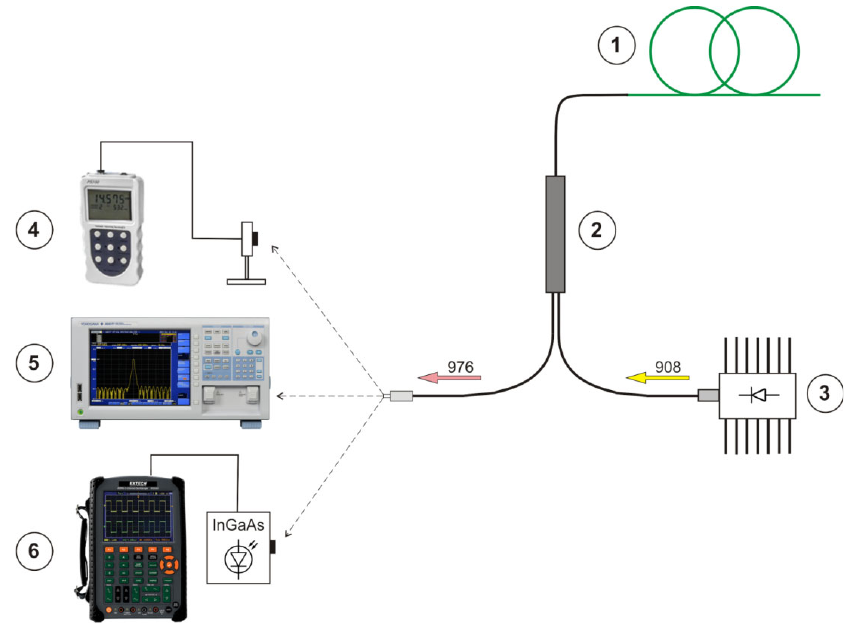
Figure 1. Scheme of the experimental setup for studying the output characteristics of a “random” laser: 1—“random” laser sample (ytterbium-doped fiber containing an array of FBGs); 2—fiber filter–multiplexer (FWDM); 3—pump source; 4—optical power meter; 5—optical spectrum analyzer; 6—photodetector connected to an oscilloscope.